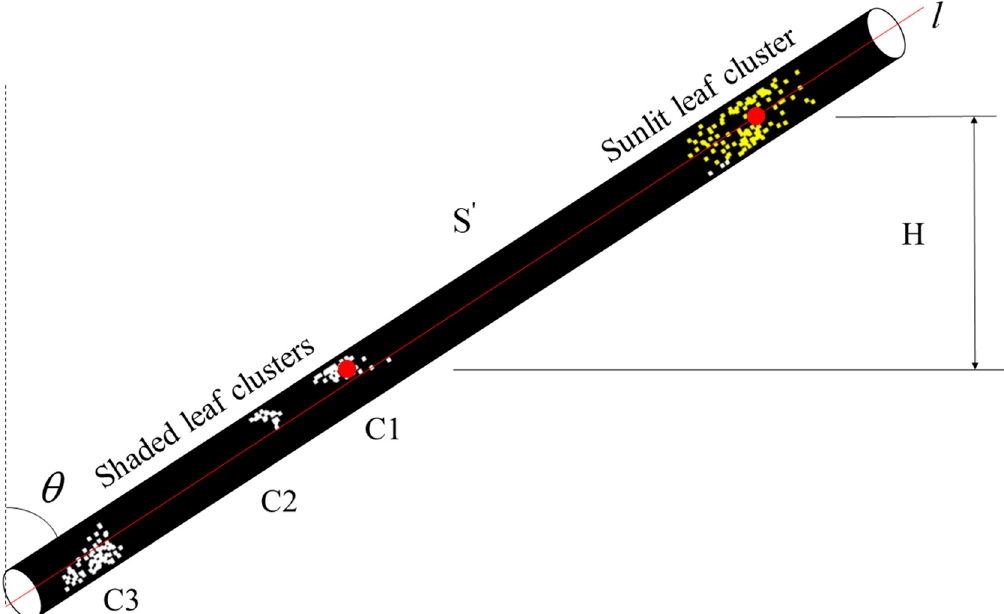
Figure 3. Schematic diagram of sunlit and shaded leaf identification based on the point cloud data within a light transmis- sion path.